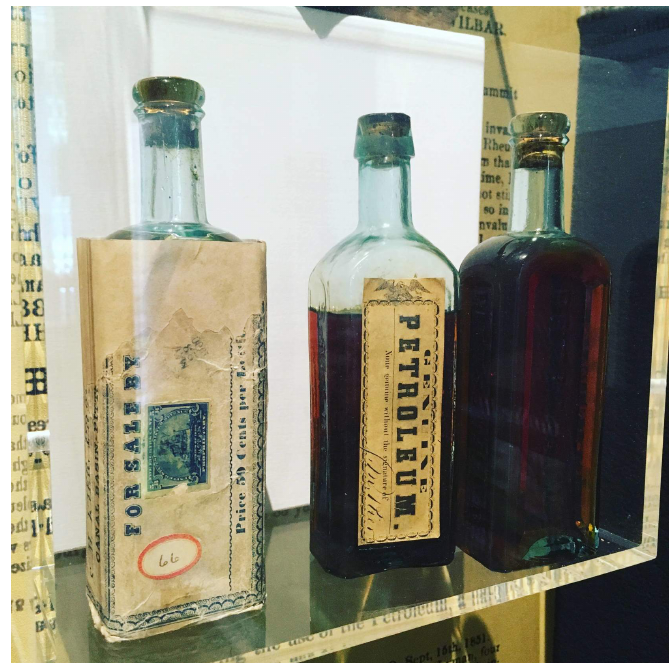
Figure 5: Historical bottle of Kier Petroleum Medicinal Ointment at Drake Oil Well Museum, Titusville, Pennsylvania. Photo: Elia